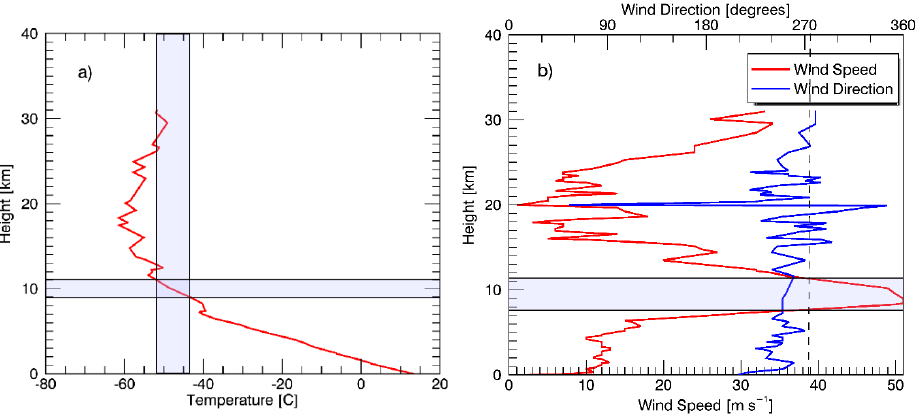
Figure 9. Comparison of the Trapani (Sicily, Italy) WMO station radiosounding vertical profiles of ( a ) the cloud temperature estimated with the darkest pixel method and ( b ) the wind speed and direction collected on 23 November 2013 at 12:00 UTC. The cloud temperature was estimated with the darkest pixel method on six different images, and the wind speed from the cloud displacement measured from two different images.